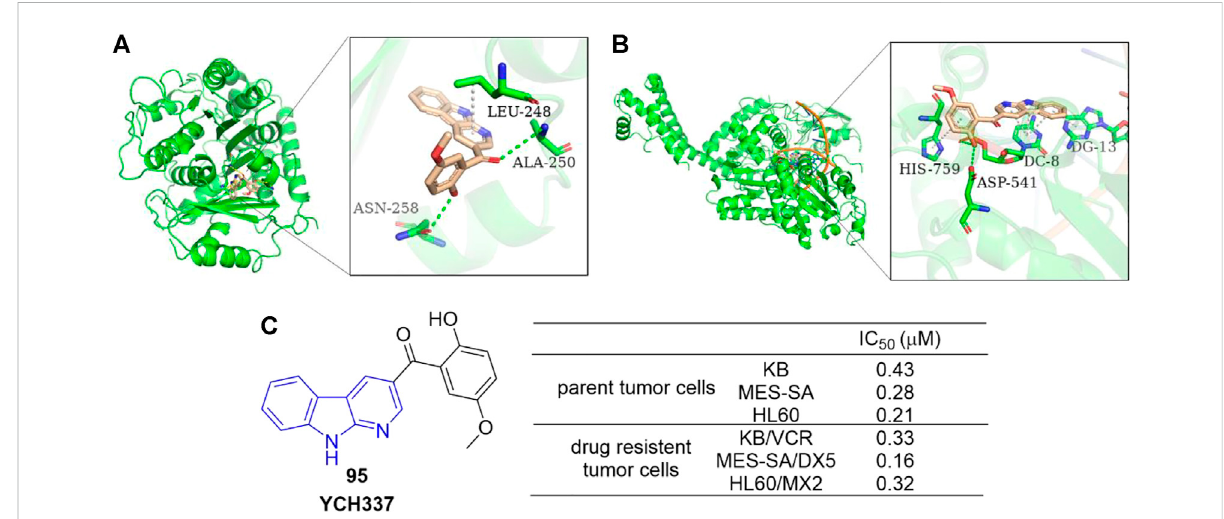
FIGURE 16 (A) Bindingmodeof 95 dockedintomicrotubule(greenribbonrepresentation,PDBcode:1SA0). 95 isrepresentedinstickmodel,carbonsin 95 are colored wheat. Hydrogen bonds are presented as green dash lines. π -sigma interaction is presented as a white dash line. (B) Binding mode of 95 docked into Top II α (green ribbon representation, PDB code: 5 gwk). 95 is represented in stick model, carbons in 95 are colored wheat. Hydrogen bonds are presented as green dash lines. π - π interactions are presented as white dash lines. (C) The structure and bioactivity of the representative compound 95 as microtubule and Top II dual